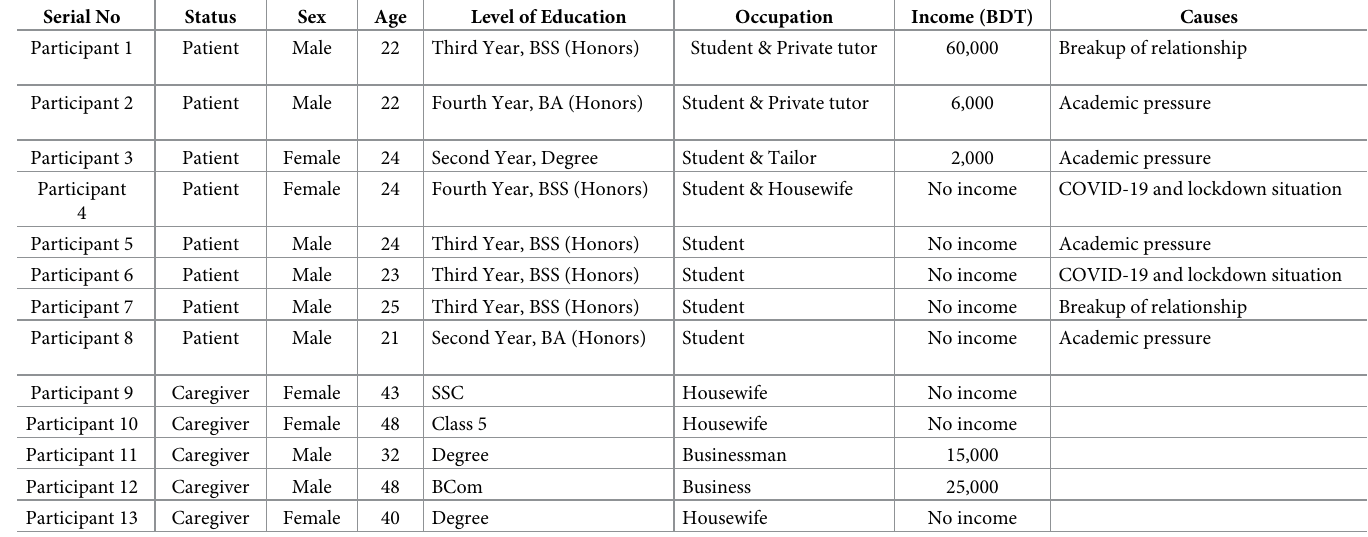
Table 1. Background information of the